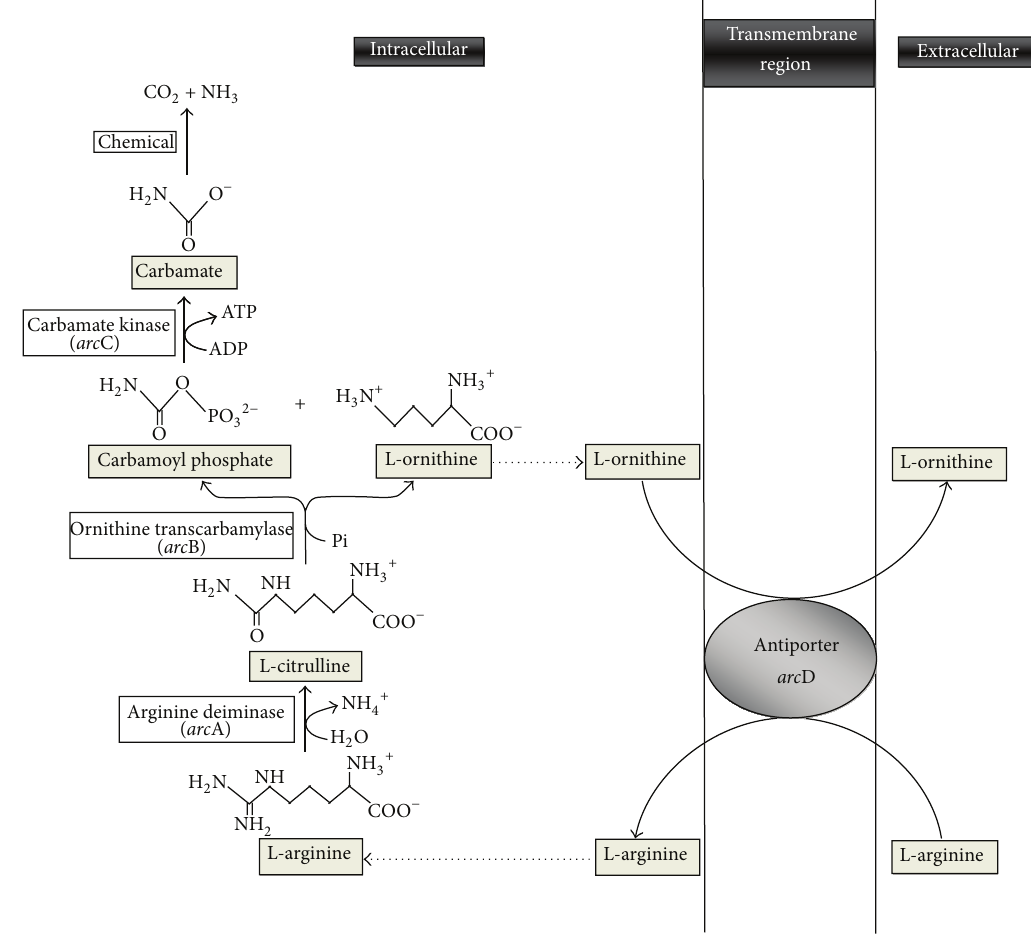
Figure 1: Arginine catabolism in E.